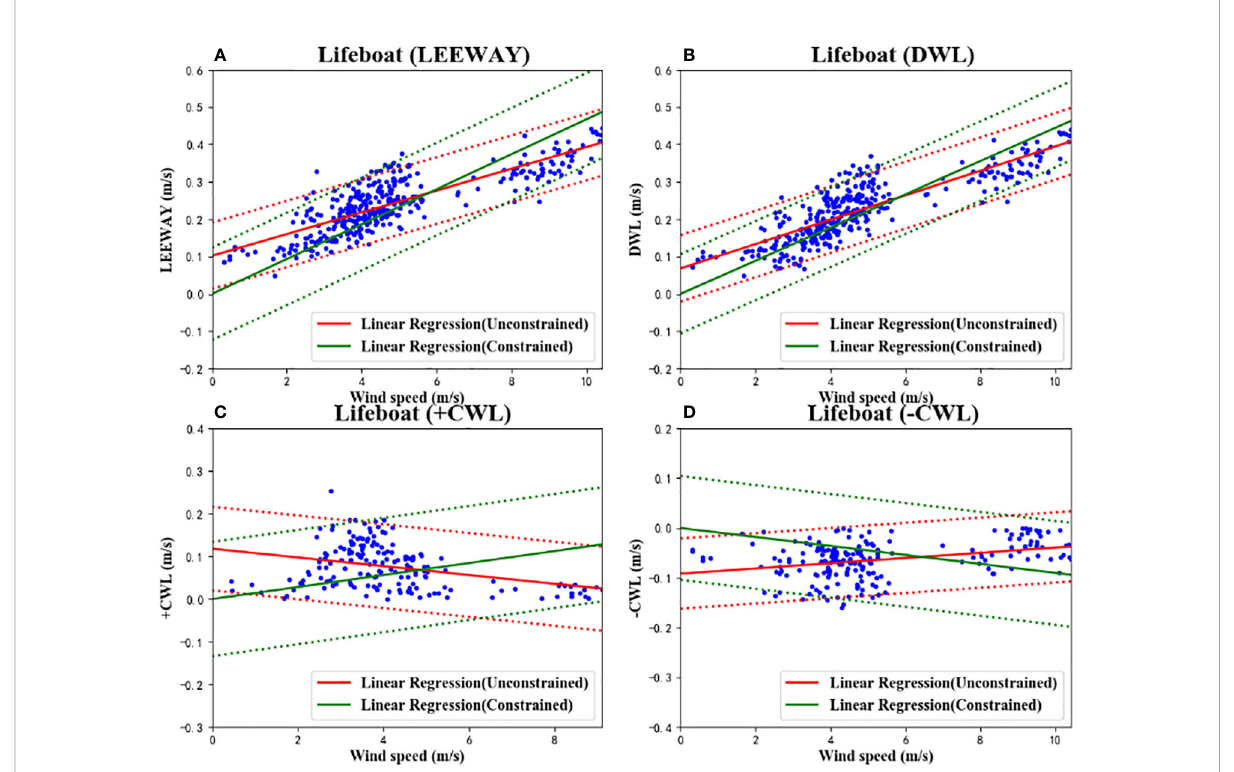
FIGURE 10 The linear regressions and 95% con fi dence level statistics of Leeway Speed (A) , DWL (B) , +CWL (C) and – CWL (D) with 10 m height wind speed for the improved drift model. Unconstrained linear regression (solid) and 95% of the con fi dence levels (dash) are plotted in red, while constrained linear regression is plotted in green